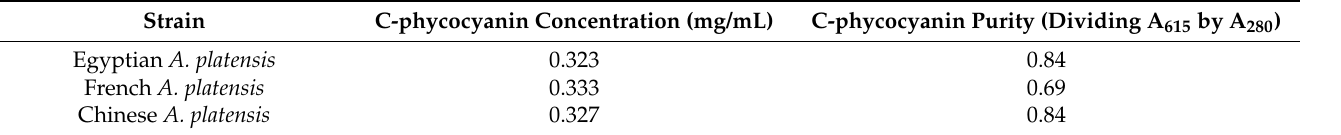
Figure 4. Visible spectrum (at wavelengths 600–650 nm) of the extracted C-phycocyanin from dry biomass of the three microalgae strains. Table 2. The concentration and purity of the extracted C-phycocyanin from dried biomass of the three microalgae strains.